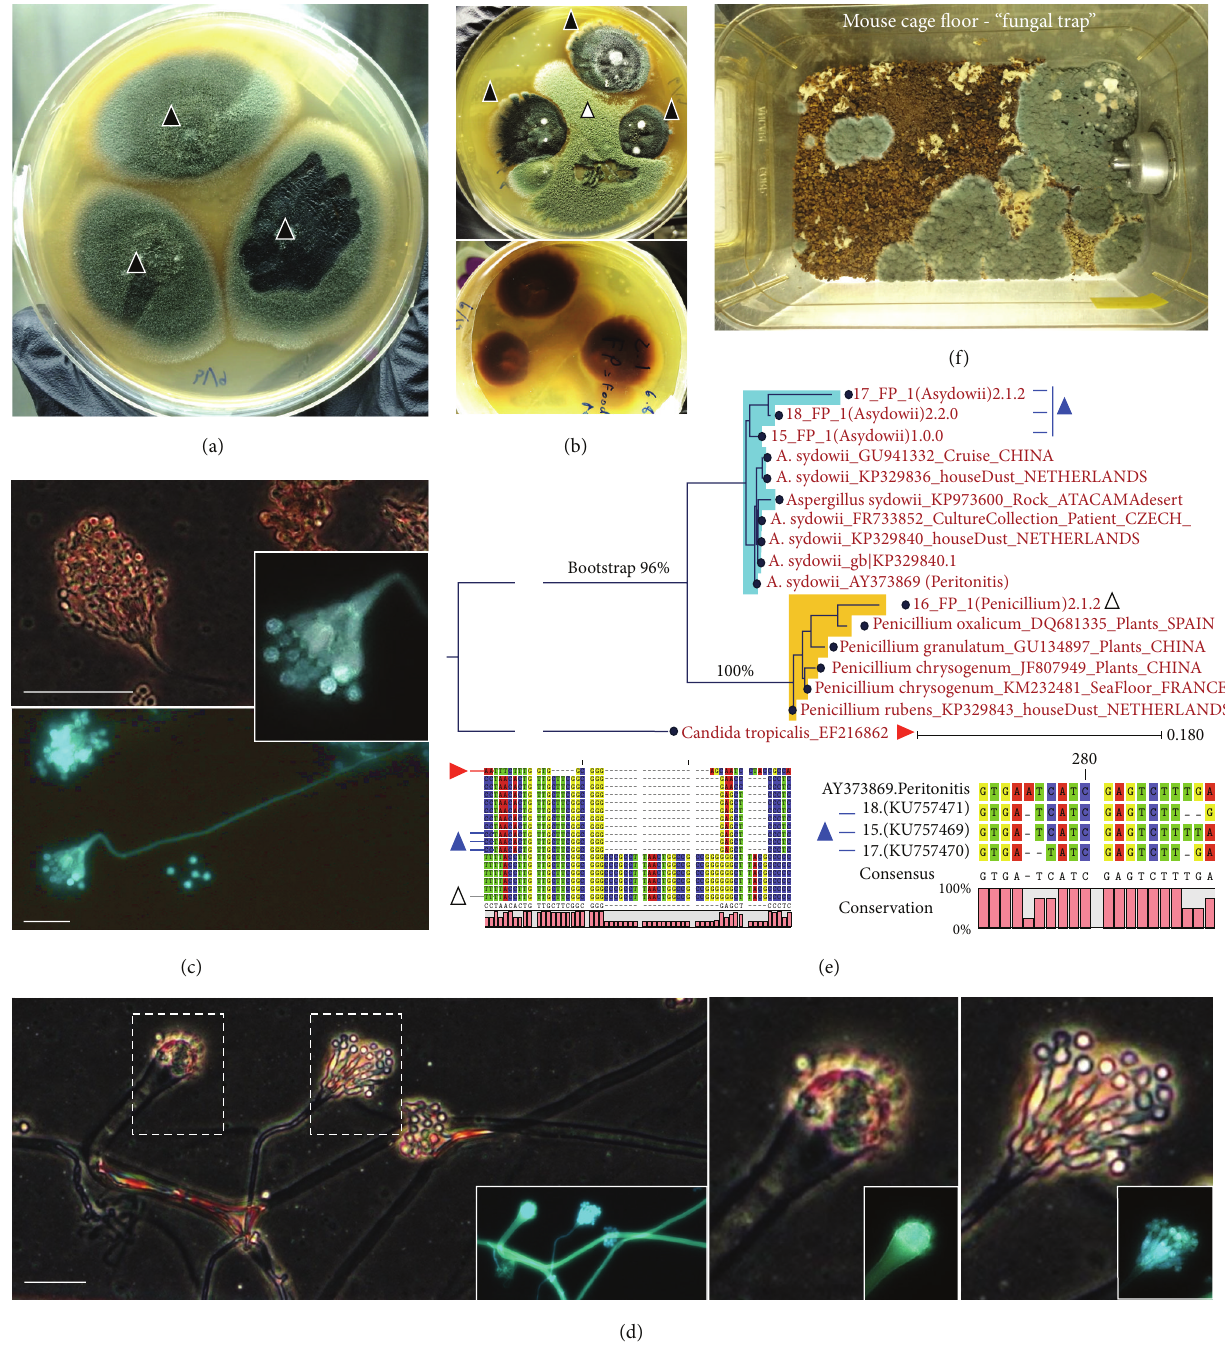
Figure 3: Culture and molecular identification of Aspergillus sydowii . (a) A. sydowii in potato dextrose agar supplemented with gentamicin andchloramphenicol(30and125 mg/L)withtypicalblue-greencolonies(solidtriangles,threedistinctisolatesfromGF-irradiatedrodentfeed in two GF isolators). (b) Coculture with a Penicillium feed isolate (open triangle) to emphasize colony morphology and pigment production by A. sydowii (transagar pigmentation). (c) Adhesive tape preparation of A. sydowii colony to illustrate conidiophores, conidia, and typical fruiting head vesicle arrangement with nonseptate conidiophore (400x; phase-contrast microscopy on Calcofluor White from Remel; Alexa Fluor 430; emission 541; absorption 433 nm; scale bar, 30 𝜇 m). (d) See distinct types of conidiophore formation by A. sydowii . (e) Neighbor- Joining phylogram of A. sydowii isolates in the context of other published 18S internal transcribed spacers ITS1–4 sequences and Penicillium spp. Notice the close-up of region where strains have sequence dissimilarity. (f) Panoramic photo of mouse cage bedding (set as “fungal trap”; i.e., mouse cage incubated for 3 weeks at 23 ∘ C) at the end of clinical observation period confirming mice were still exposed or shedding A. sydowii